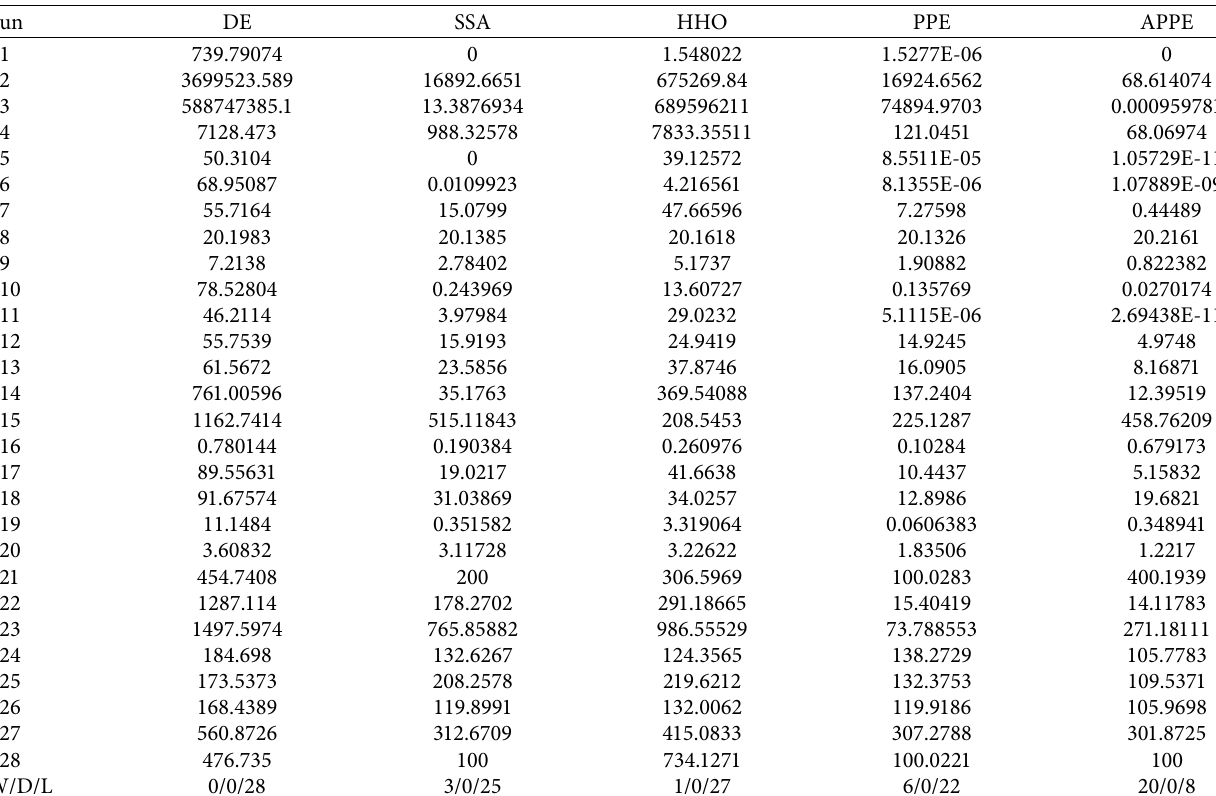
Table 2: Comparison of the best result of 51 runs on 10D in 28 benchmark